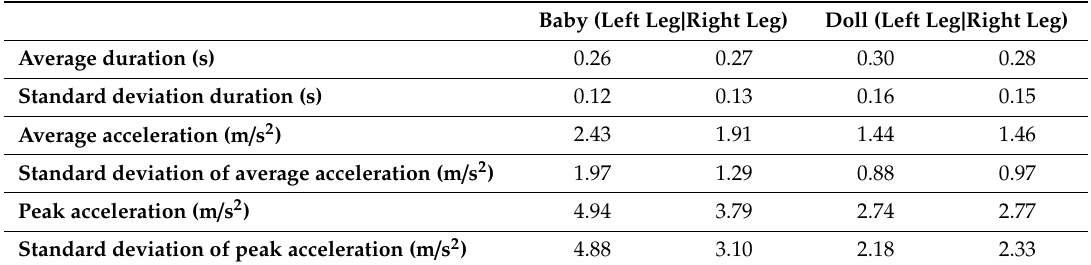
Table 2. Acceleration and duration of individual leg movements, average values across a full day. Baby (Left Leg | Right Leg) Doll (Left Leg | Right Leg) Average duration (s) 0.26 0.27 0.30 0.28 Standard deviation duration (s) 0.12 0.13 0.16 0.15 Average acceleration (m / s 2 ) 2.43 Standard deviation of average acceleration (m / s 2 ) 1.97